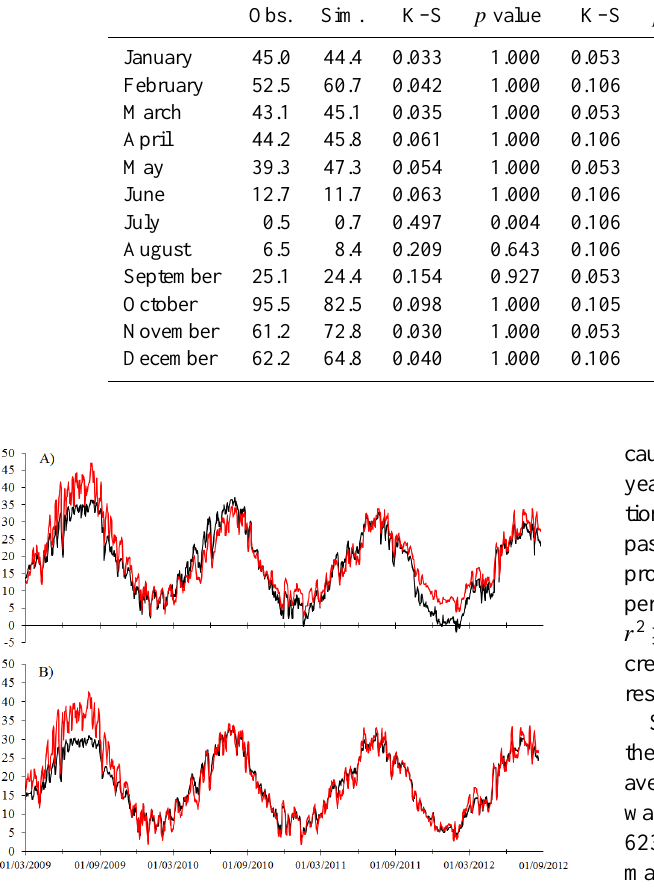
Fig. 4. Observed and simulated soil temperature from March 2009 to September 2012. (A) Site 1; (B) site 2; Black line are measured values, and red line are simulated